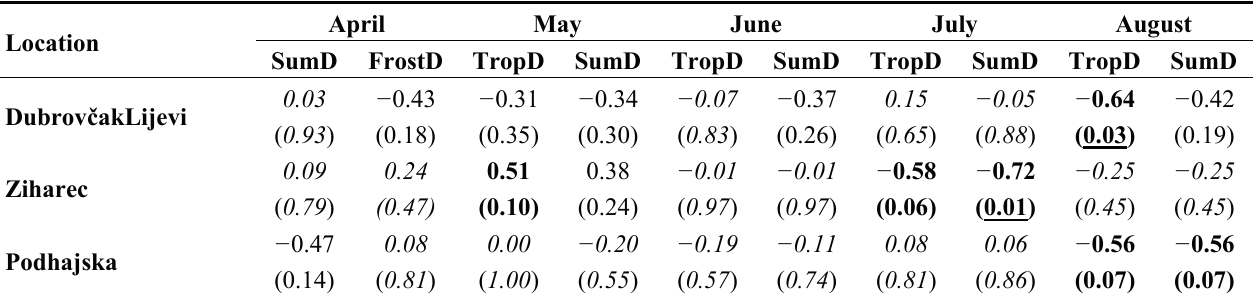
Table 6. Correlation coefficients and p values (in brackets, underlined values are significant) between AMI describing number of days with extreme temperatures and observed MZ yield. No effect: 17 of 30 ; with effect: 6 of 30 . April May Location